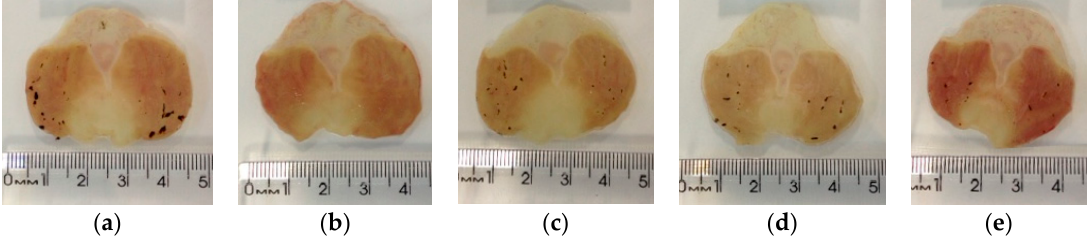
Figure 8. Typical photograph of the gastroprotective effect of aqueous extract of X. americana (XaAE) stem bark on indomethacin-induced (30 mg/kg, s.c.) gastric lesions in rats. ( a ) Lesioned control (NaCl 0.9%, 10 mL/kg, orally); ( b ) pantoprazole (40 mg/kg, orally); ( c – e ) XaAE (100, 200 and 400 mg/kg, orally, respectively). Table 3. Effect of X. americana (XaAE) aqueous extract on gastric secretion parameters in Wistar rats subjected to pylorus ligation.